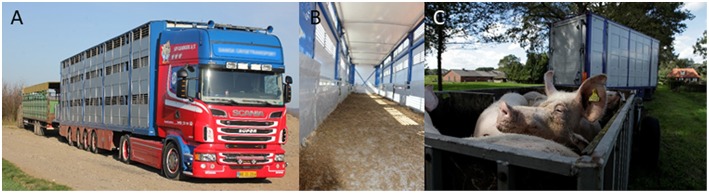
(A) Example of commercial truck of the type involved in the study. In the picture, the truck is parked close to the mobile pick-up facility. (B) The inside of the truck after removal of one deck, showing the sawdust bedding and inside walls (Credit for these two photos: Photo: Carsten Kjærulff Christensen). (C) Example of the type of trailers that were used in the study. The sows in the front are waiting in the mobile pick-up facility before loading (Credit Photo: Colourbox). The photos exemplify the procedures used but were not from the study.